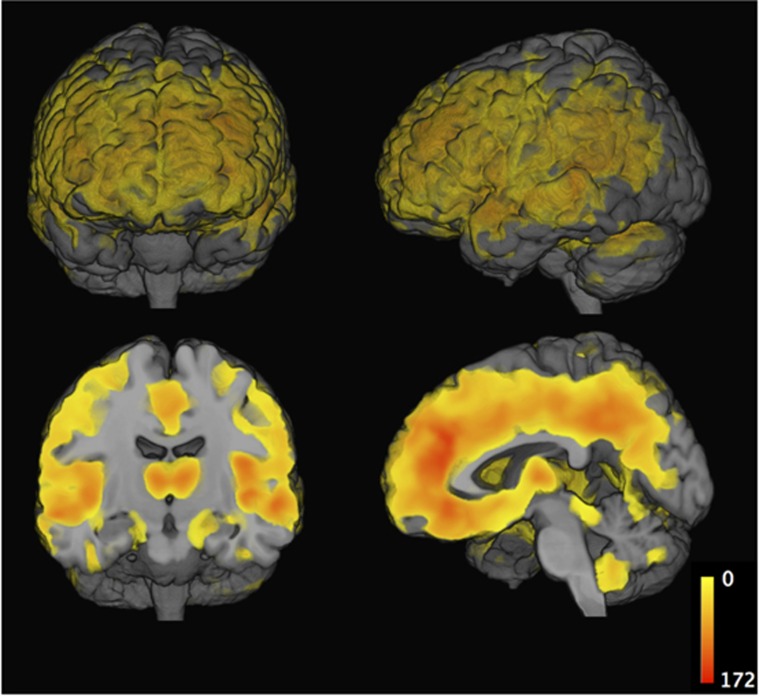
Regional gray matter volume differences between resilient aging (n=191) and advanced aging (n=179) subjects. Results are significant at level P<0.001, and all survived FDR correction with q<0.001. FDR, false discovery rate.